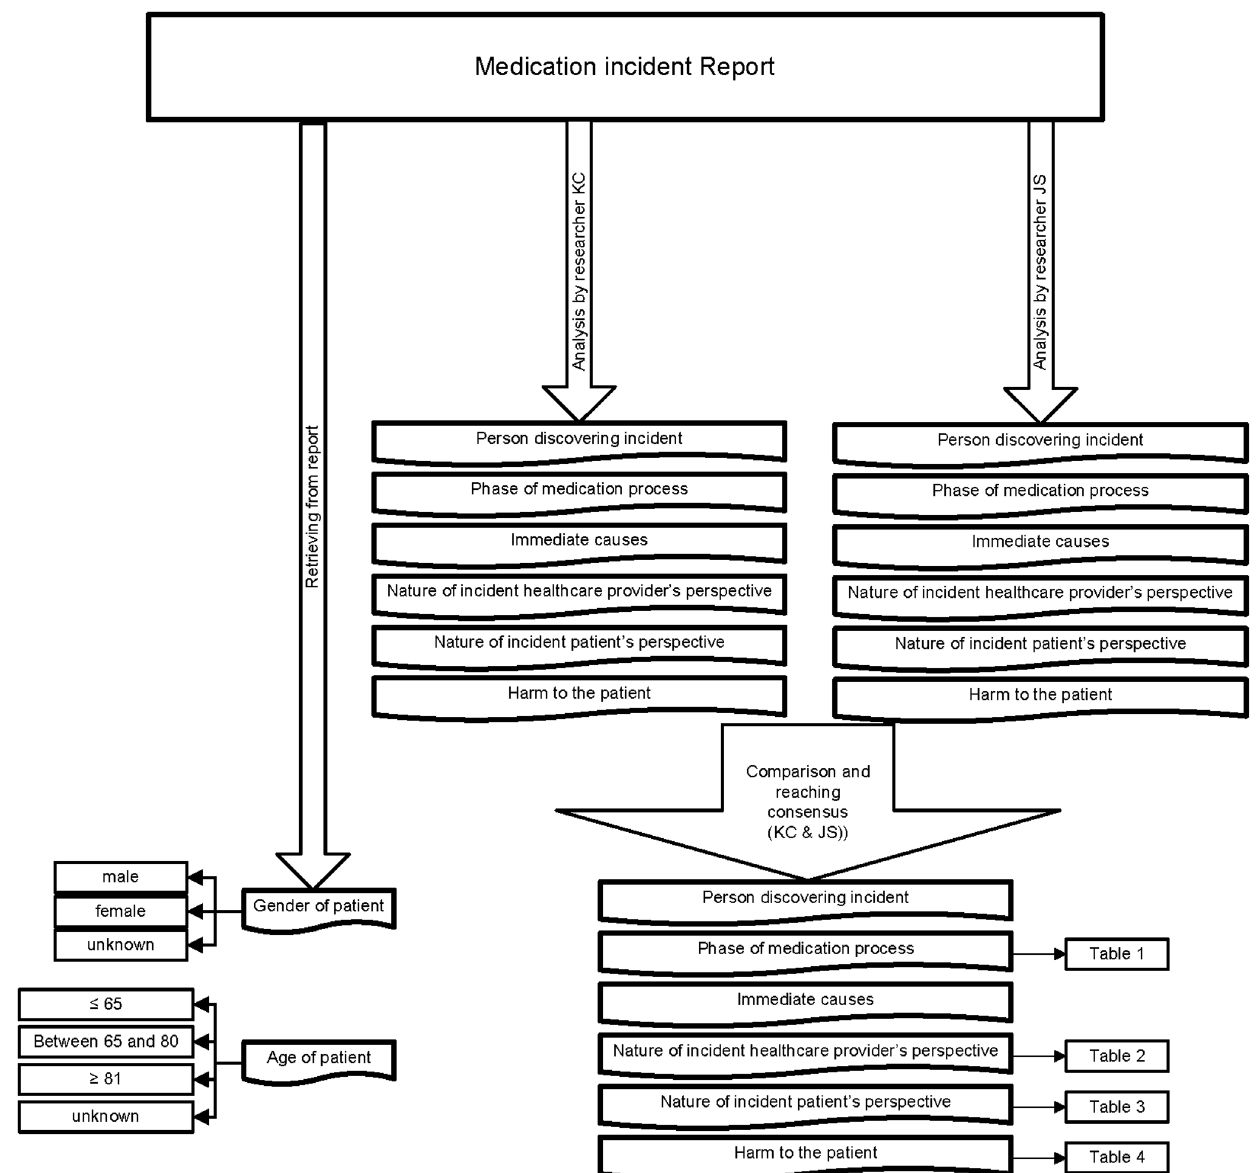
Figure 2. Flowchart of analysis medication incident reports.